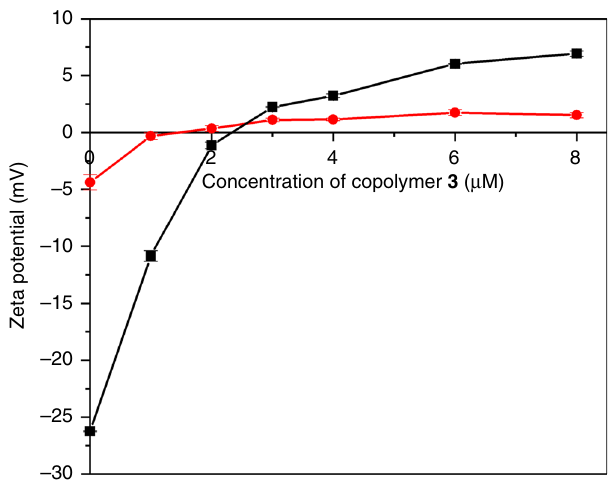
Fig. 7 Surface charge neutralization by zeta potential study. Changes of zeta potential of P. mirabilis (black box) and B. subtilis (red circles) cells membrane in the presence of copolymer 3 . Each data point is the average of two independent experiments and error bars represent